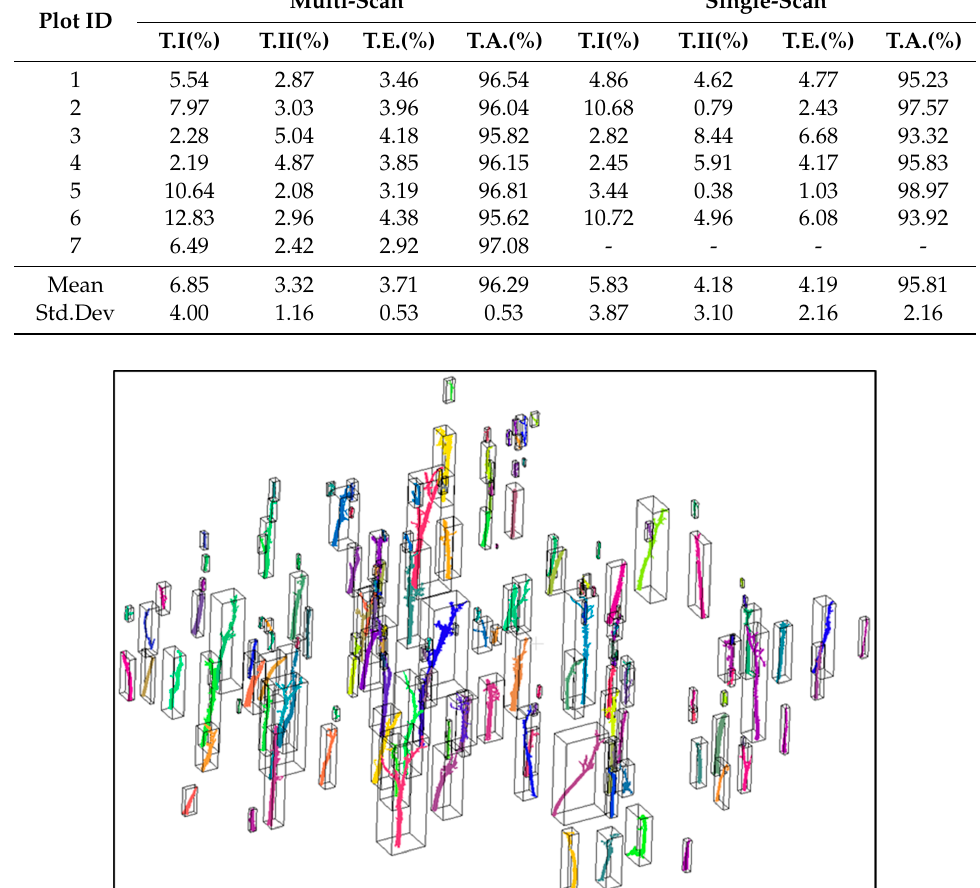
Figure 10. Tree stem point extraction of the plot with diverse stem forms using the proposed method. filtering using a height-to-width ratio threshold (1.5). The segments were assigned random colors. It demonstrates that the segments of slanted and curving stems were correctly reserved, which means that the height-to-width ratio of all stem segments was larger than the specified height-to-width ratio in this